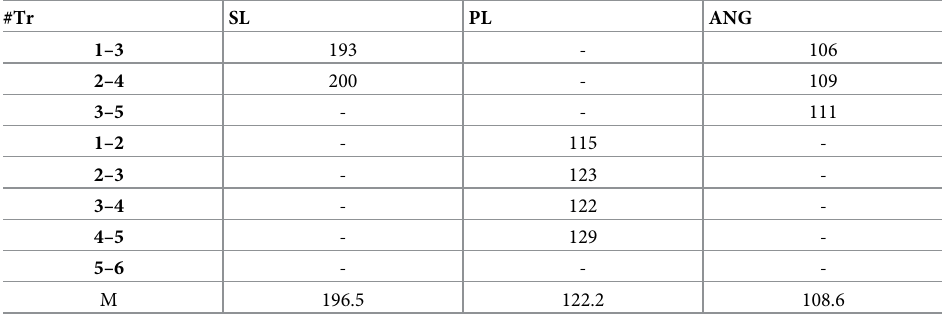
Table 4. Trackway variables.